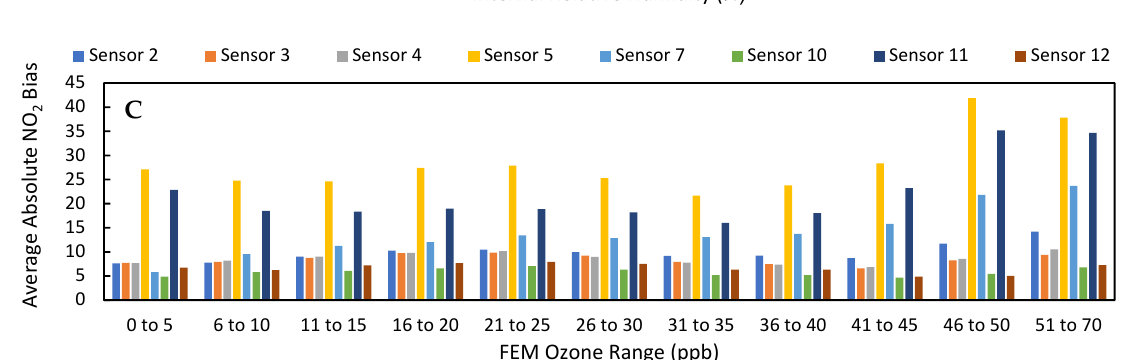
Figure 5 . ( A ) The average absolute bias of the raw LCS NO 2 data binned by internal temperature values. ( B ) The average absolute bias of the raw LCS NO 2 data binned by internal relative humidity values. ( C ) The average absolute bias of the raw LCS NO 2 data binned by West Phoenix FEM O 3 values.